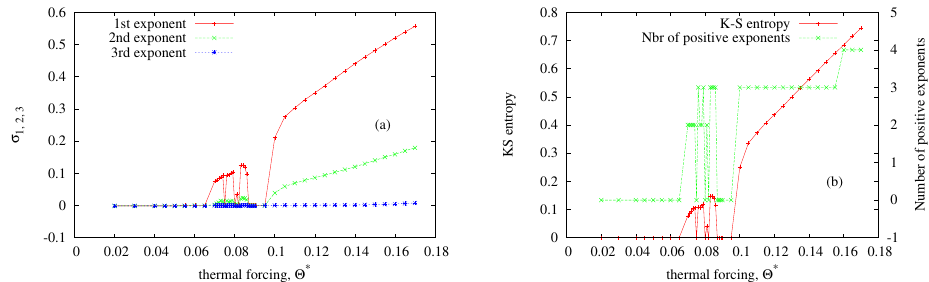
Fig. 5. Values of the first three Lyapunov exponents, (a) , and the Kolmogorov–Sinai entropy and the number of positive Lyapunov exponents, (b) , as a function of θ ∗ for δ = 0 . 001938 .